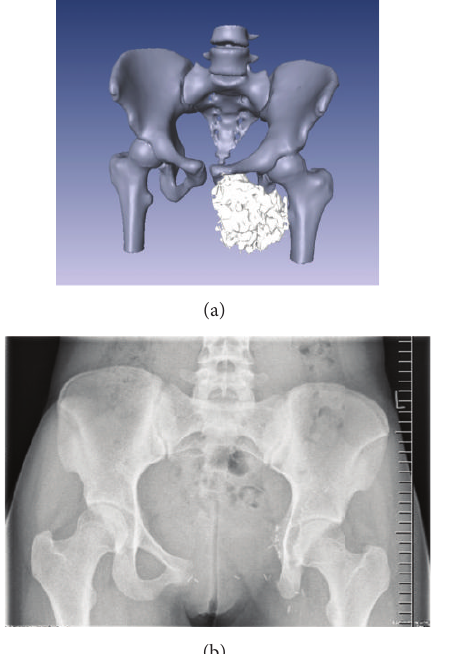
Figure 4: (a) CT reconstruction of the pelvis of a 15-year-old girl with a chondrosarcoma of the left os pubis and os ischii. (b) Anteroposterior radiograph after P3 resection.